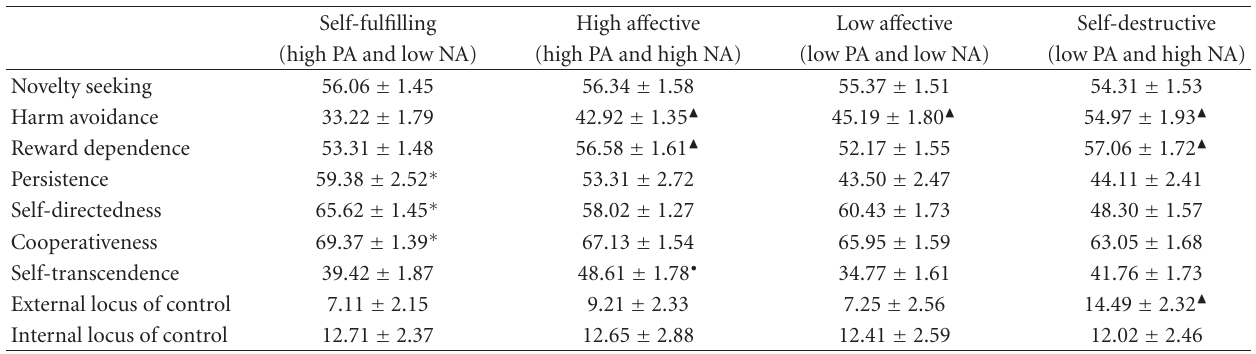
Table 3: Mean ( ± SD) scores for temperament, character, and locus of control among a ff ective